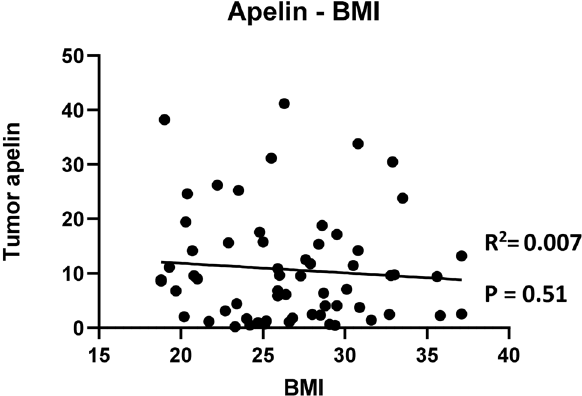
Figure 2. Correlation between tumor apelin expression and BMI of patients (N =